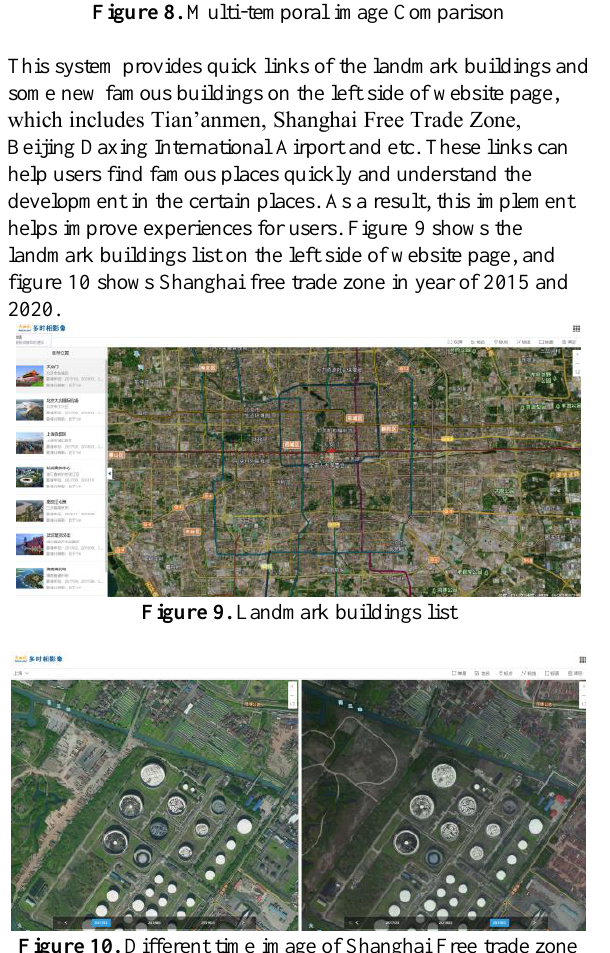
Figure 10. Different time image of Shanghai Free trade zone